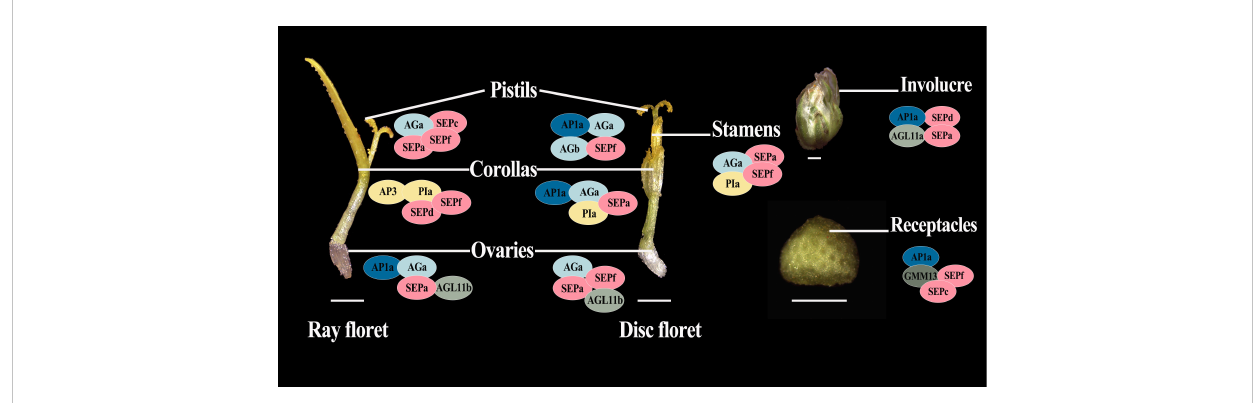
FIGURE 6 Suppositional interaction model of the four most highly expressed ClMIKCc in the nine fl oral organs of C. lavandulifolium . Different colors are used to distinguish the members of the different clades. Intersecting ellipses indicate that the protein pair has interactions. All positive results are supported by the Y2H and LCA results. bar=1